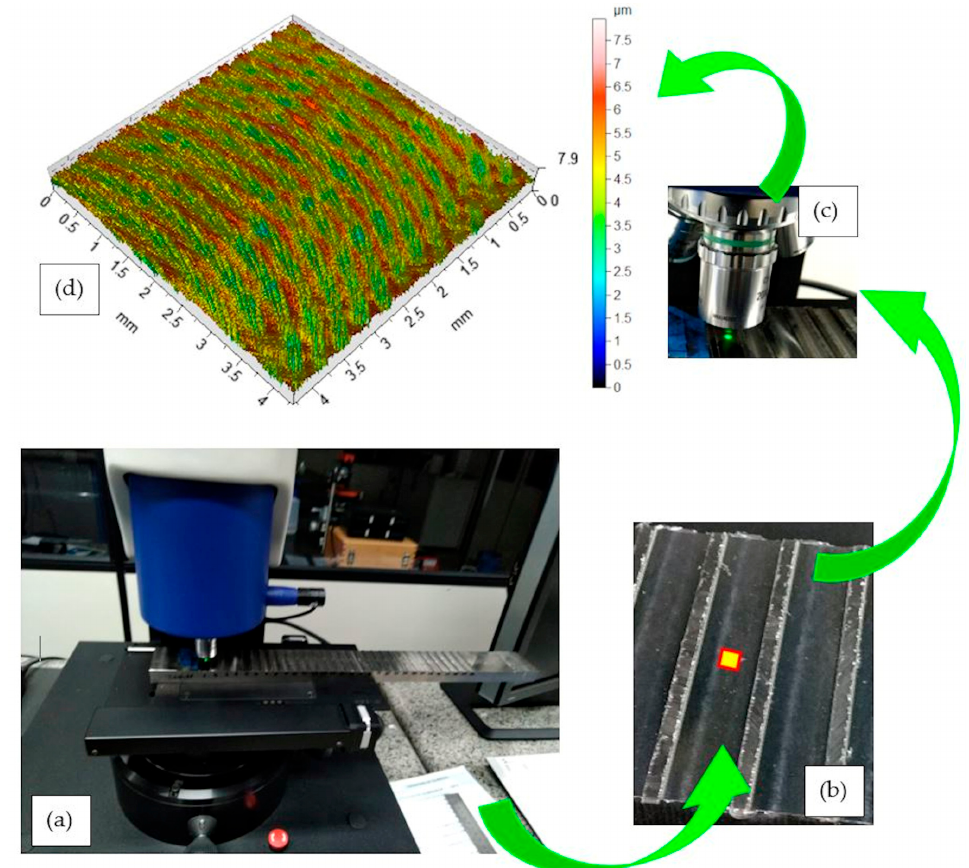
Figure 9. Roughness measurement procedure. ( a ) Taylor Hobson/Talysurf CCI Lite white light interferometer ( b ) Position and application area. ( c ) Measurement being performed. ( d ) Milled 3D surface topography.